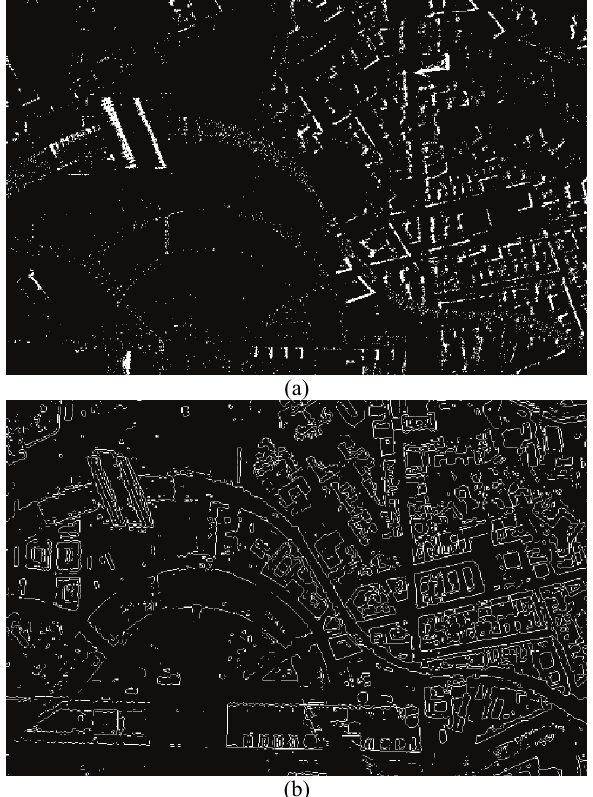
Figure 4. (a) A crop of the edge image of the TomoSAR point cloud in downtown Berlin, and (b) the edge image of the reference optical point cloud roughly at the same area.